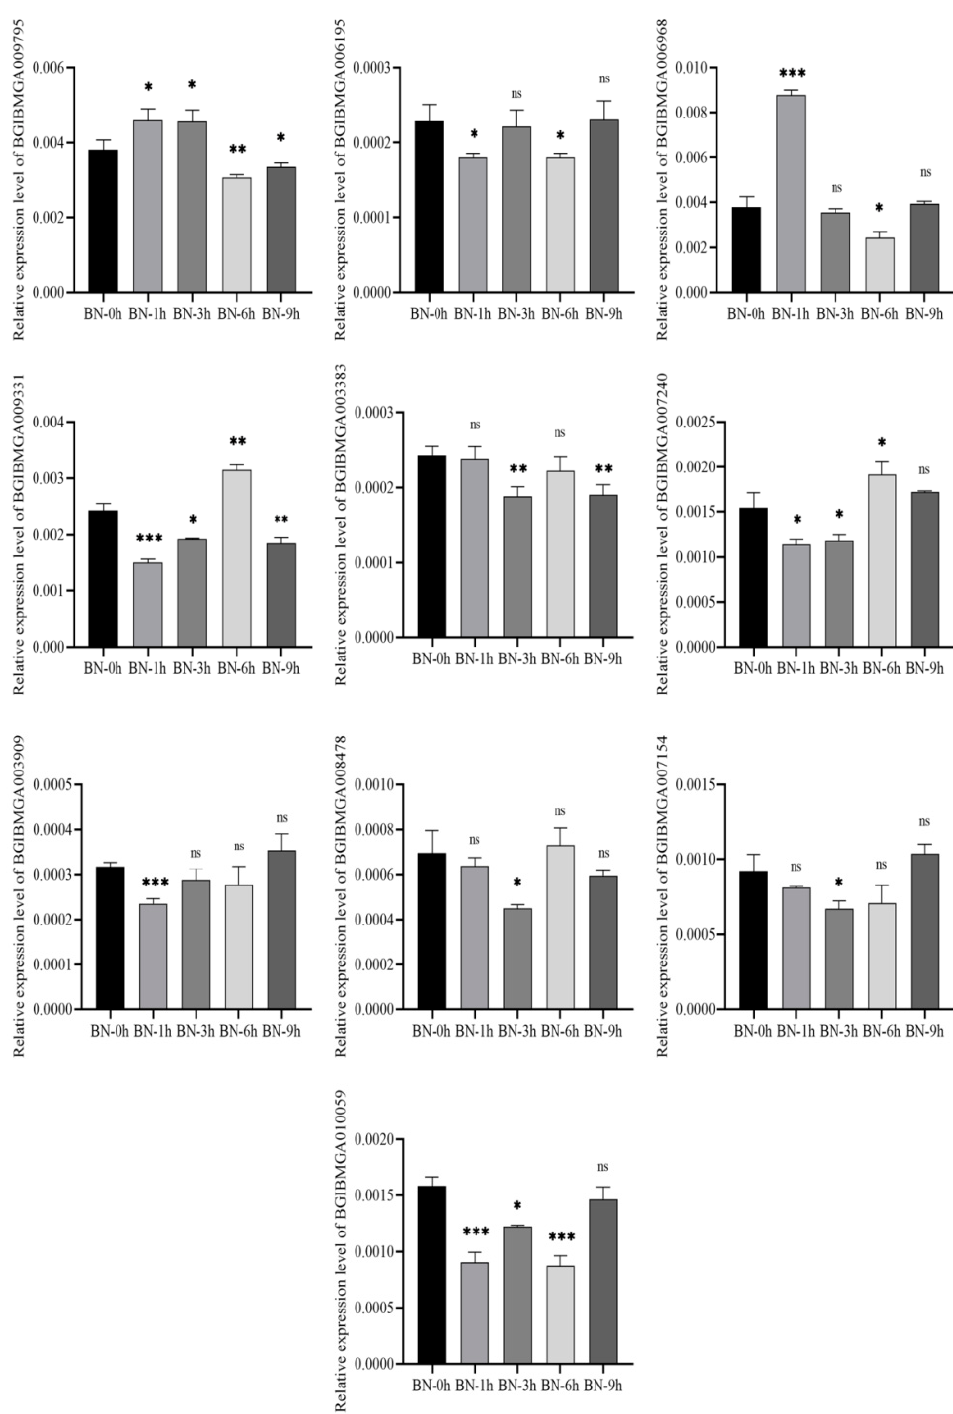
Figure 8. Quantification of 10 DEGs at 1, 3, 6, and 9 h after BmNPV infection in the BN variety by qRT-PCR. Significant differences are indicated by asterisks ( p < 0.05). ns, not significant. *, p < 0.05; **, p < 0.01; ***, p < 0.001.